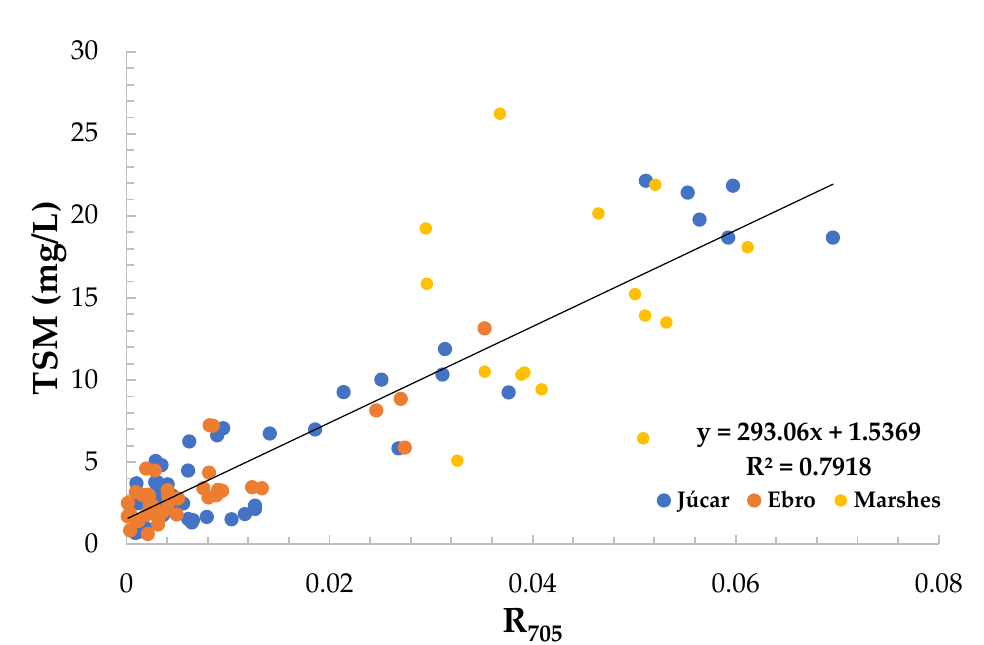
Figure 9. TSM in situ data in function of R 705 using all data under 30 mg/L. Reservoirs located in the Ebro watershed are those with the lowest amounts of sus- pended solids, while the Albufera marshes have the highest values. Reservoirs located in the Júcar watershed present more varied values.